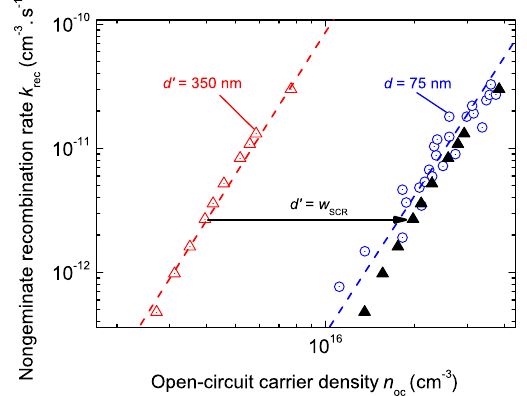
FIG. 7. Measured recombination rate k (cid:3) function of carrier rec concentrations at open circuit n for two DPP-TT-T − PC 71 BM OC devices with an active-layer thickness in the range of 75 nm (open circles) and 350 nm (open triangles). Both devices belong to the same series with a high doping level N A ¼ 7 × 10 16 cm − 3 . If now the recombination rate of the device d ¼ 350 nm is calculated with the effective width w of the space-charge region instead SCR of the total active-layer thickness, the recombination rate (solid triangles) coincides with the thin undoped